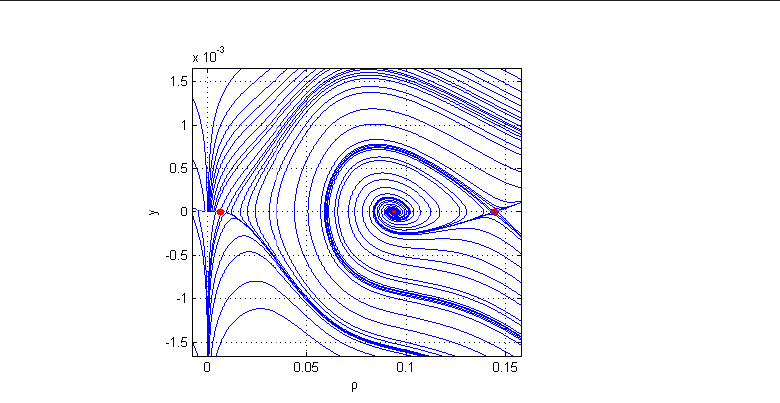
Fig. 1. Phase plane y-  trajectory diagram, where traveling wave velocity 371.1  c , traveling wave parameter 2.0q *  .